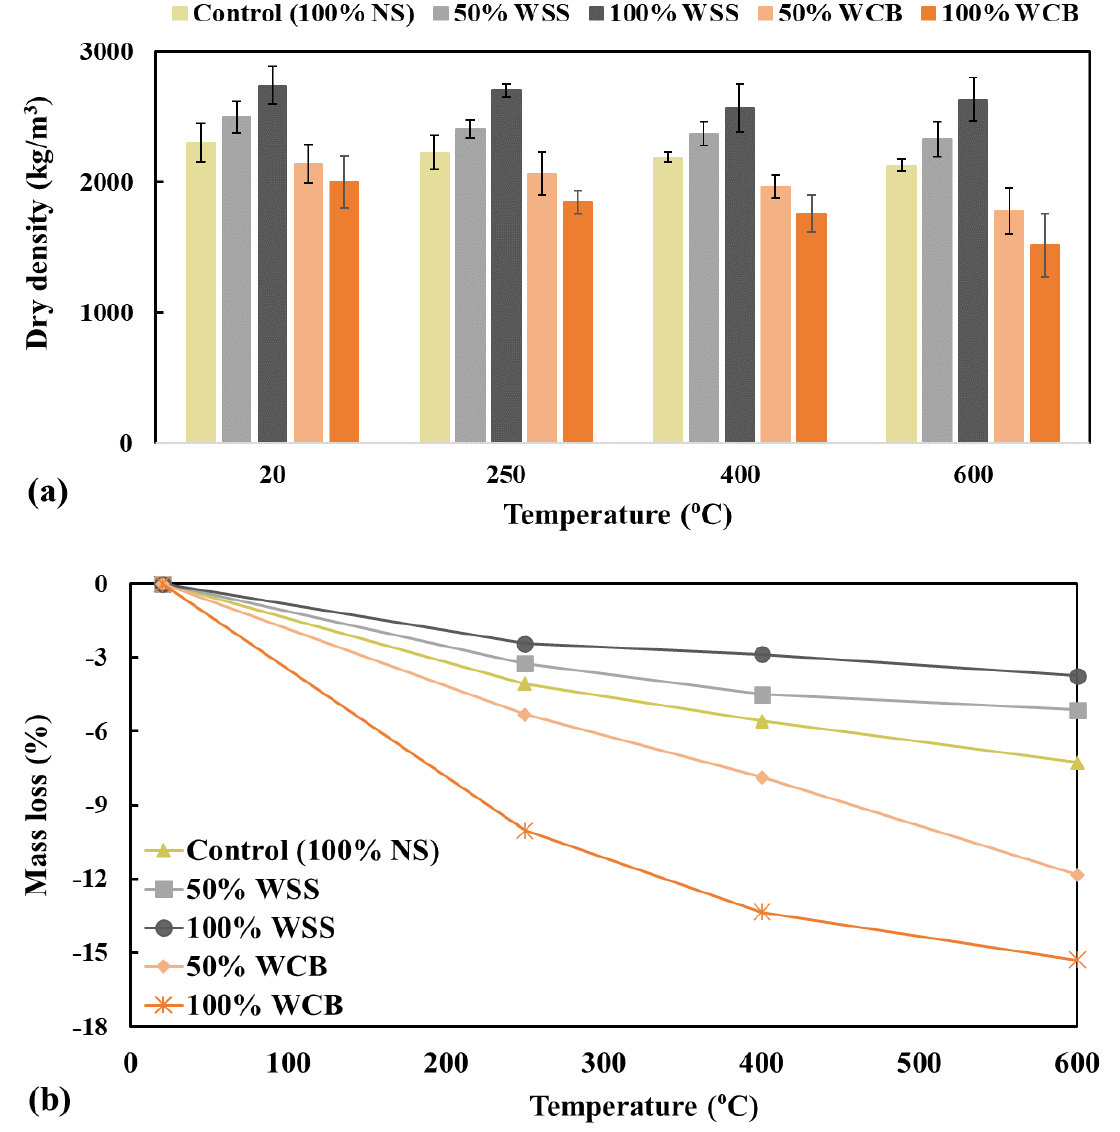
Figure 7. Dry density ( a ) and mass loss ( b ) of the mortar mix after exposure to elevated temperatures. This behavior is directly linked with the specific gravity and unit weight (2.56 and 1598.3 kg/m 3 for NS, 3.24 and 1919 kg/m 3 for 100% WSS and 1.70 and 1422 kg/m 3 for 100% WCB) of the materials, the specific gravity and unit weight of which increased by 27 and 20%, respectively, for WSS and decreased by 34 and 11%, respectively, for WCB compared to NS. As the temperature increased, the dry density of all the mortar mixes decreased, and the decrease in density was more significant at higher temperatures (e.g., 400 and 600 ◦ C). The dry density after exposure to 600 ◦ C of the mortar mix made with 100% NS, 100% WSS and 100% WCB were 2129, 2635 and 1518 kg/m 3 ,